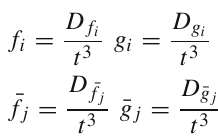
parameters in Eq. (4) result from the factorization approach [30], written as